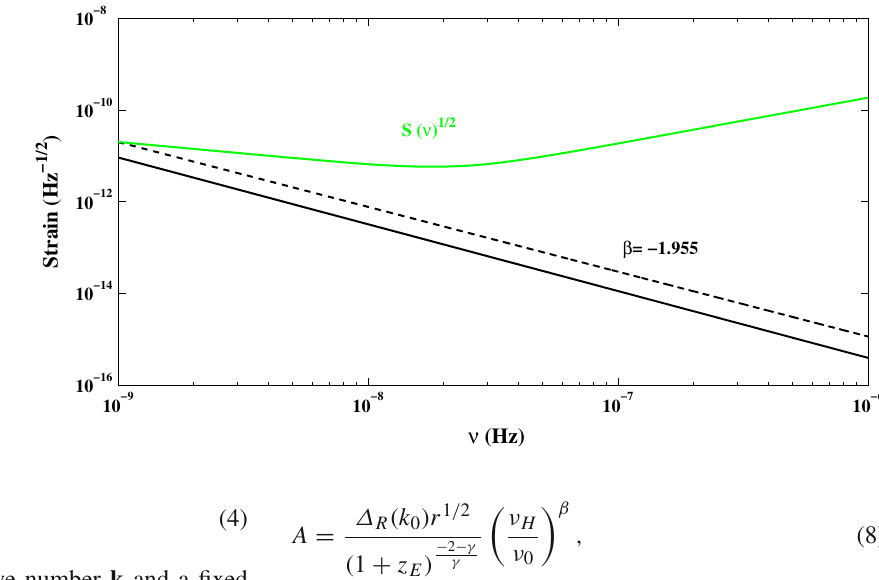
Fig. 1 The spectrum √ h mc (ν) F /ν of RGWs in usual case (solid line) and thermal case (dashed line) compared to the strain sensitivity of PT (green